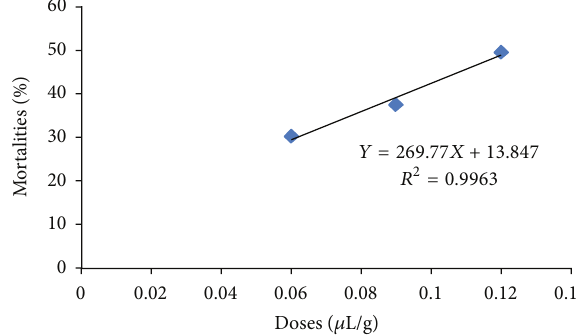
Figure 4: Evolution of mean cumulated percentages of in vivo mortalities in terms of doses of the essential oils of C. ambrosoides contained in the